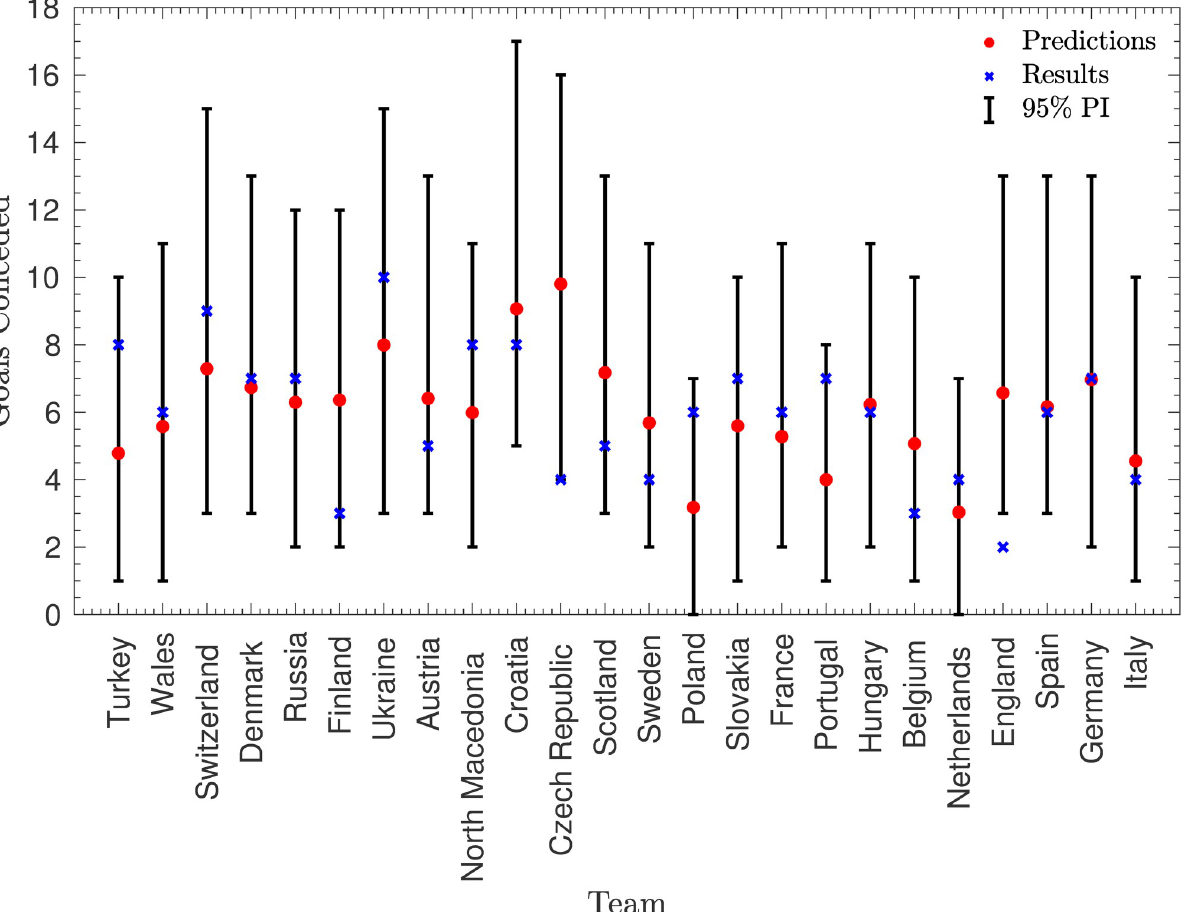
Fig 9. Predicting goals conceded by each team. The number of goals conceded by each team, alongside the predicted (mean) number of goals conceded and an approximate 95% prediction interval.